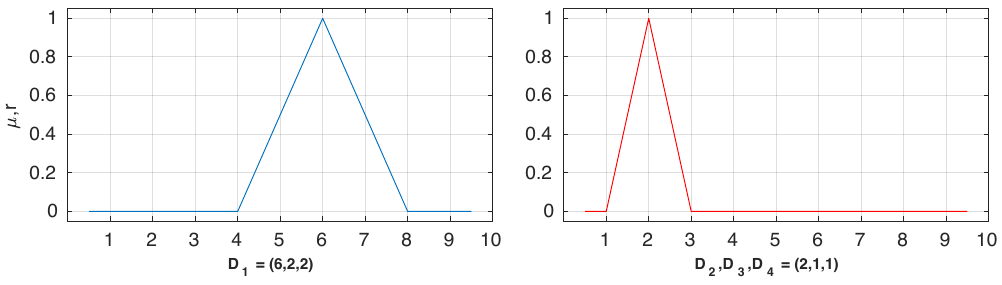
Figure 4. Triangle fuzzy numbers D 1 , D 2 , D 3 , D 4 used as uncertain coefficients in the discussed benchmark Problem 1.